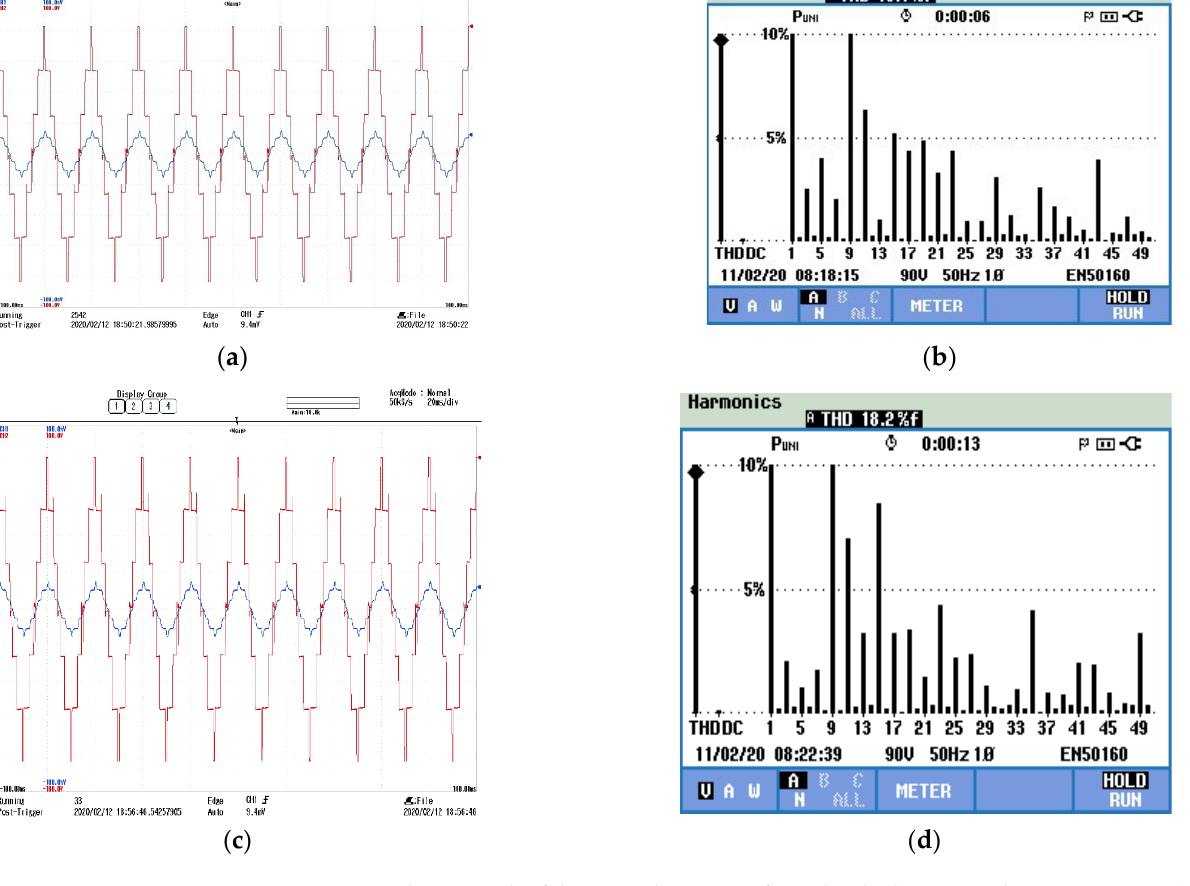
( d ) Figure 17. Hardware result of the Quasi-linear MLI for 9th order harmonic elimination using: ( a ) the conventional technique; ( b ) THD analysis of the conventional technique; ( c ) the proposed tech- nique; and ( d ) THD analysis of the proposed technique. 6. Conclusions